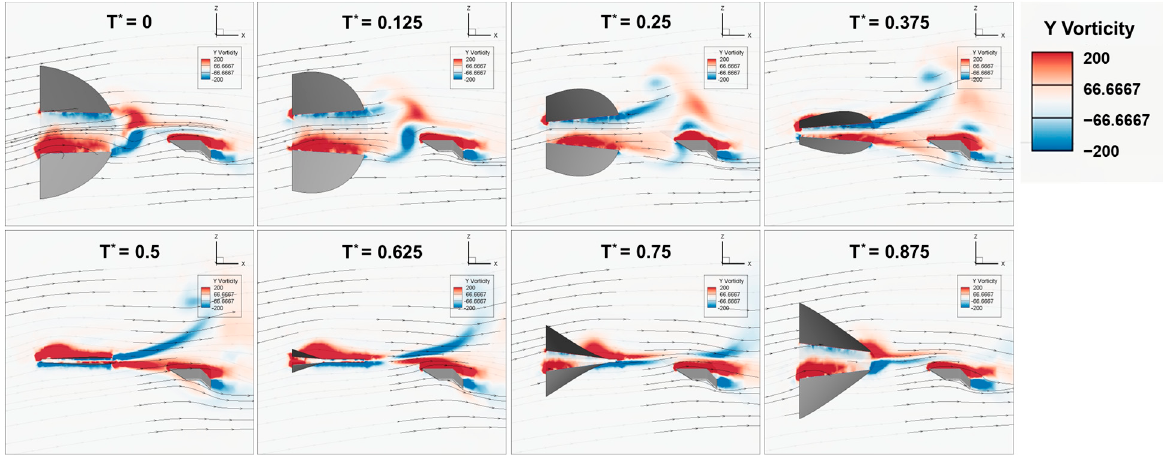
Figure 22. Vorticity and streamlines in the section of y = 0.15 span with the inverted V-tail. When T ∗ was approximately 0.5, the flapping wings switched from instrokes to outstrokes. The attached vortex on the flapping wing was ‘squeezed out’. The vortices of the inside surfaces of the flapping wings gradually fell off and flew to the tail. The attached vortex on the upper surface of the tail was remarkably enhanced, causing another larger peak in the force of the empennage, as shown in point B in Figure 23. Therefore, there were two maximum effects in a period. The range of the curve during a period was approximately 62% times the average pitching moment.